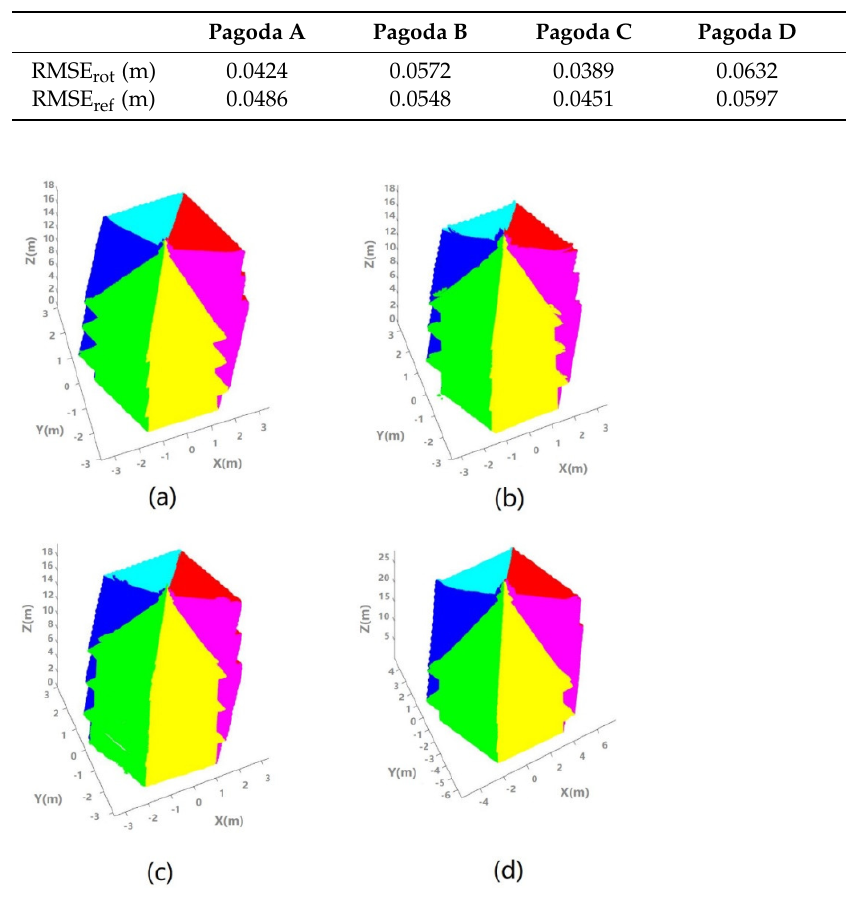
Figure 13. Sextant number obtained from the least-squares estimation as a byproduct for the symme- try analysis: ( a ) Pagoda A; ( b ) Pagoda B; ( c ) Pagoda C; and ( d ) Pagoda D. Red: q = 1; Cyan: q = 2; Blue: q = 3; Green: q = 4; Yellow: q = 5; Magenta: q =